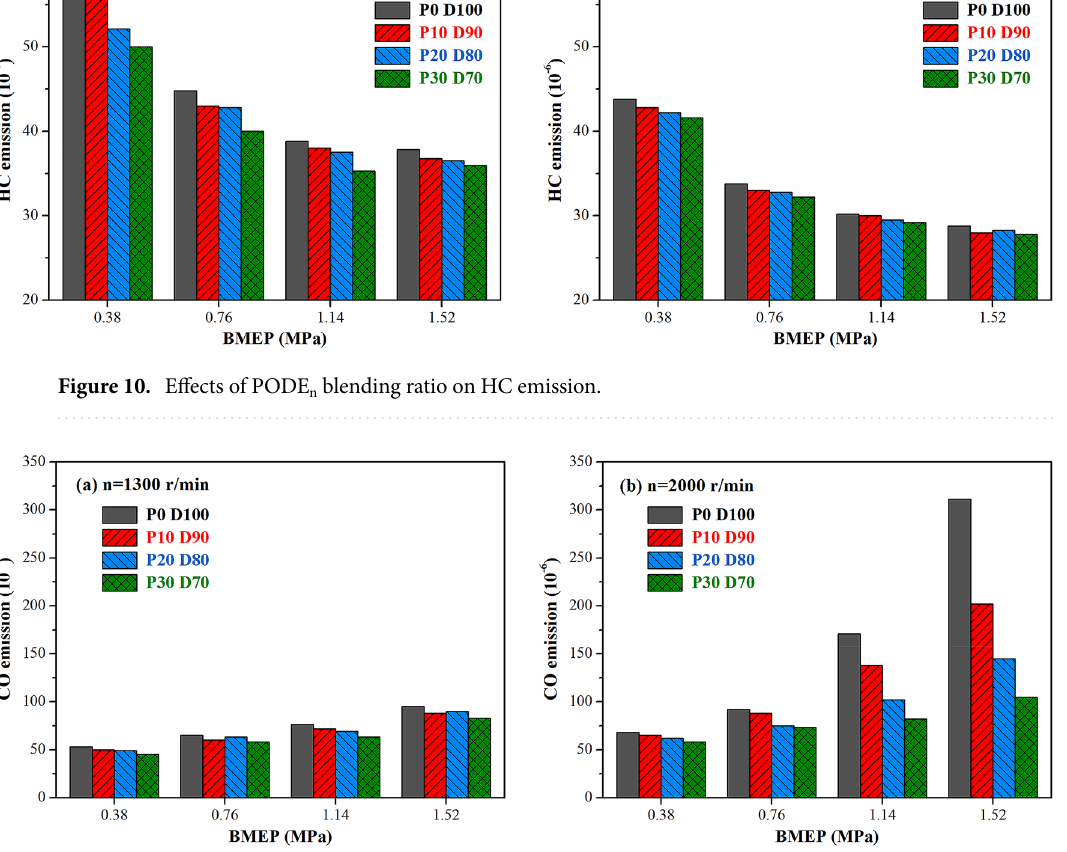
Figure 11. Effects of PODE n blending ratio on CO